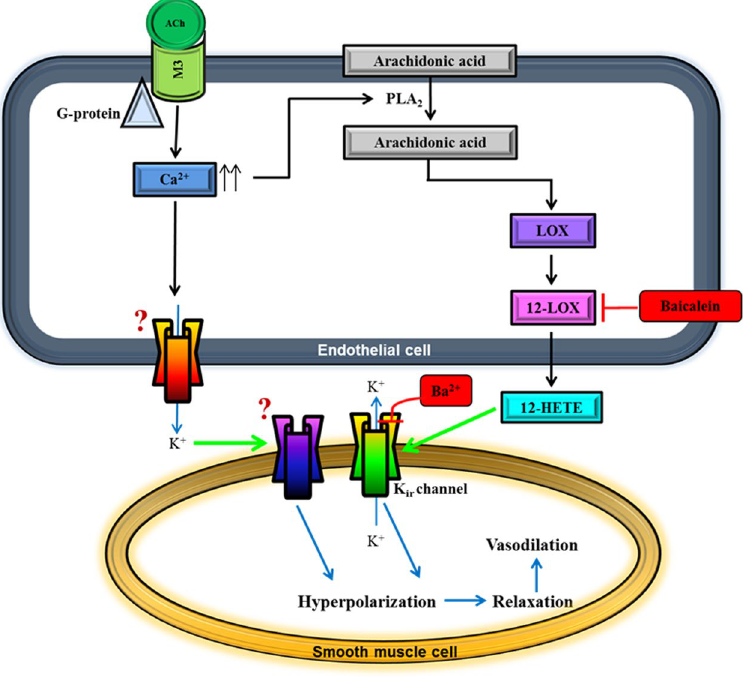
Figure 9. Proposed scheme for endothelium-dependent compensatory mechanisms responsible for mediating ACh-induced vasodilation in the ophthalmic artery of mice deficient in the eNOS gene. Endothelium-derived hyperpolarizing factor (EDHF)-mediated dilatory responses to ACh involve two mechanisms acting in parallel. In the first pathway, stimulation of the muscarinic ACh receptor (M 3 ) coupled to G protein of class G q on vascular endothelial cells mediates a transient increase in intracellular calcium, [Ca 2 + ]i. Elevated endothelial [Ca 2 + ]i activates phospholipase A2 (PLA 2 ) to release arachidonic acid (AA) from cell membrane. Free AA is metabolized via the 12-LOX pathway to produce relaxing factors, namely 12-HETE, which activates Kir channels on the smooth muscle. In the second pathway, it is hypothesized that elevated [Ca 2 + ]i also initiates activation of putative K + channel(s) and release of K + ions from the endothelial cell. These K + ions diffuse to the adjacent vascular smooth muscle cell in concentrations sufficient to activate another putative K + channel. Both pathways eventually cause hyperpolarization of the smooth muscle cell membrane and vasorelaxation. The precise identities of the putative channels hypothesized to be present in the ophthalmic artery of eNOS − / − mice that facilitate K + efflux on the endothelial cell and are activated on the smooth muscle cell for downstream spread of hyperpolarization are unknown. Question marks represent unknown channels that remain to be identified. Inhibitor and blocker are indicated in red boxes. Green arrows indicate channel activation.12- HETE, hydroxyeicosatetraenoic acid; Kir, inward rectifying K +